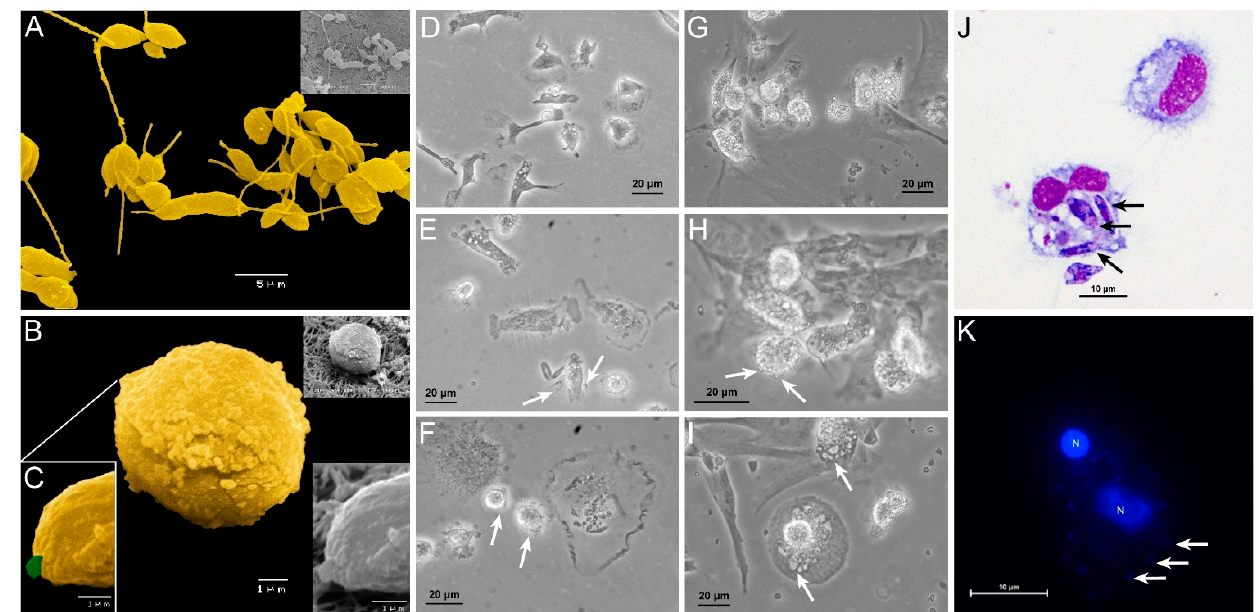
Figure 1. Canine blood-MØs and KCs exposed to L. infantum virulent promastigotes or axenic amastigotes. L. infantum virulent promastigotes (yellow) showing elongated flagellum characteristic of L. infantum metacyclic promastigotes ( A ) and axenic amastigotes ( B ) with a characteristic oval body (yellow) and residual flagella ( C ) (green) were observed under SEM. The acquired images were artificially colored. Blood-MØs (uninfected- D ) were exposed to virulent promastigotes for 3 h ( E ) and 5 h ( F ). Interaction of promastigotes with the MØ membrane can be observed (white arrows) along with parasite internalization ( E , F ). Uninfected KCs ( G ) and KCs exposed to axenic L. infantum amastigotes for 1.5 h ( H ) and 5 h ( I ). Internalization of amastigotes by KCs (white arrows) can be observed ( I ). Blood-MØs exposed to virulent L. infantum promastigotes for 3 h stained with Hemacolor staining kit were observed by optical microscopy (magnification 1000×) ( J ). Black arrows indicate promastigote internalization. KCs exposed to L. infantum amastigotes for 3 h and stained with DAPI ( K ) (blue) were observed by fluorescence microscopy. Acquired images show parasites binding to the KCs membrane. N-KCs nucleus.